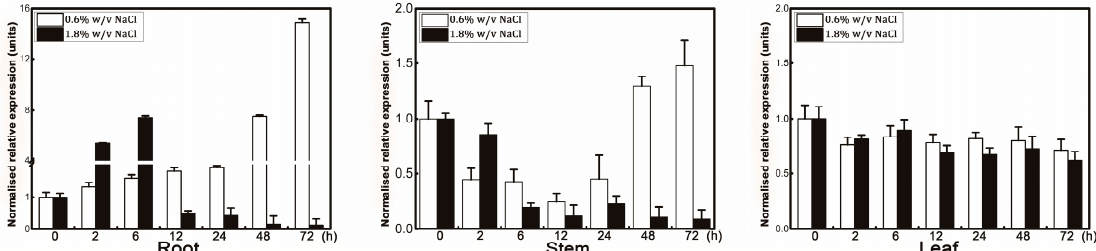
Figure 3. Expression level of PeHKT1;1 in “Nanlin895” poplar under NaCl stress. Six ‑ week ‑ old poplar plants were treated with 0.6% and 1.8% w / v NaCl solution for 0, 2, 6, 12, 24, 48, and 72 h, and roots, stems, and leaves were harvested for qRT ‑ PCR assay. Standard deviations were calculated from three independent qRT ‑ PCR experiments.